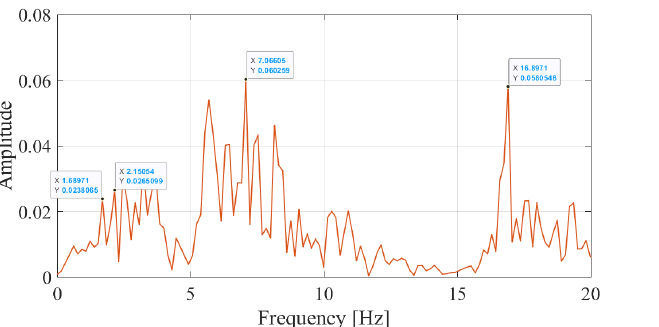
Figure 18. Fourier Amplitude Spectrum of the accelerations recorded on the bogie for a speed of 90